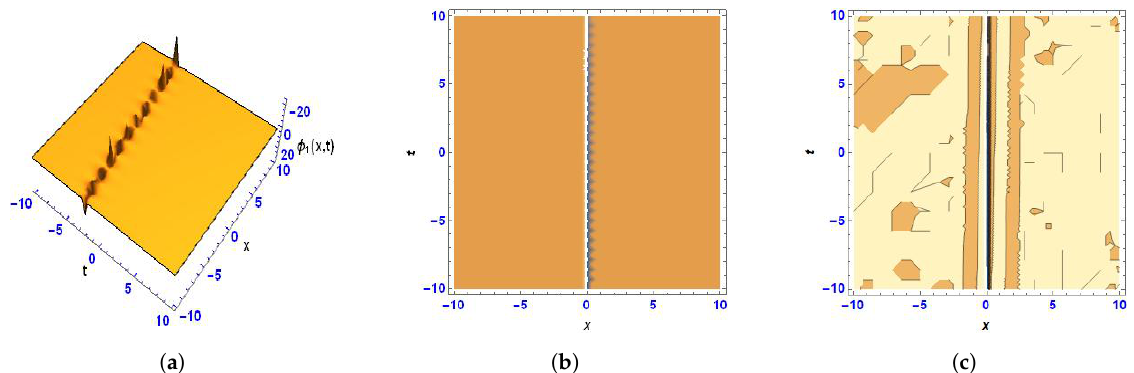
Figure 1. ( a ) Three-dimensional, ( b ) density, and ( c ) contour images of (6) under the values ϑ 0 = 6, ϑ 1 = 0.75, γ 1 = −